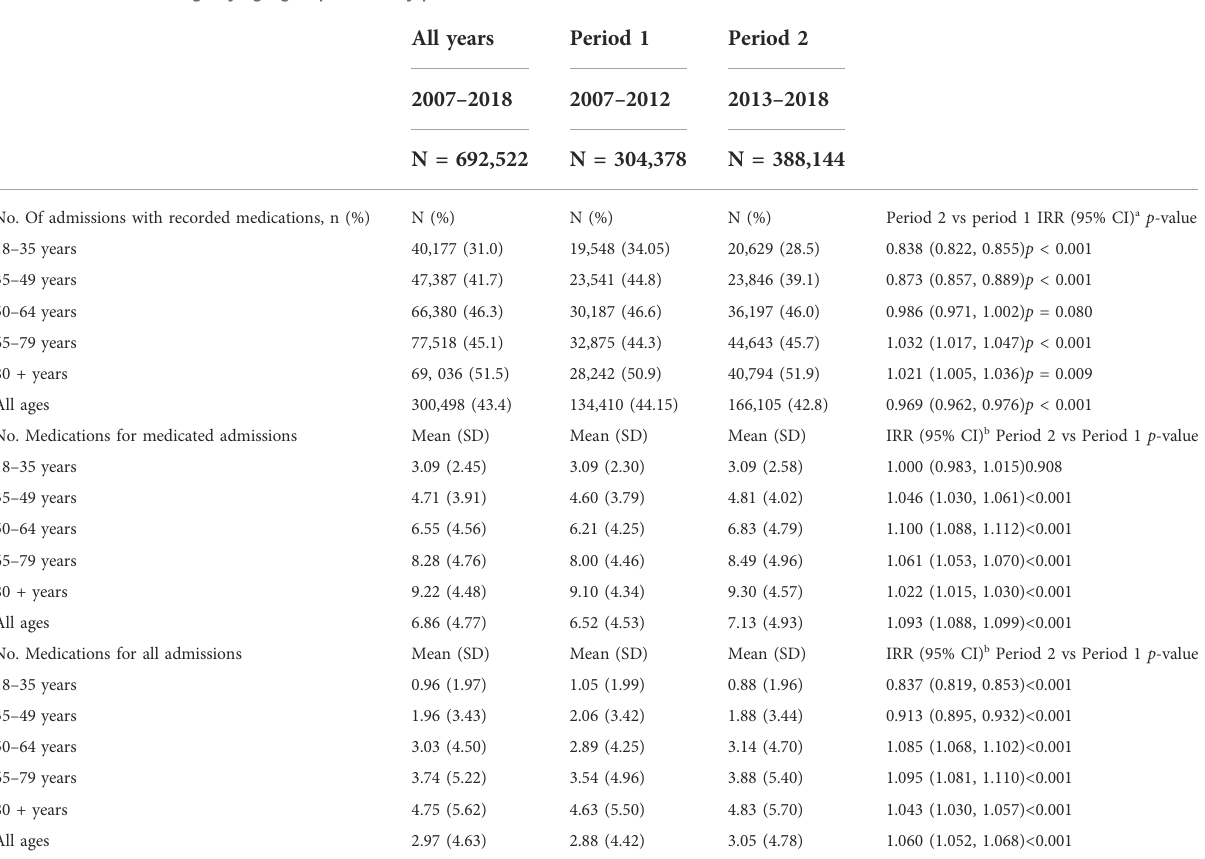
TABLE 2 Medication usage by age-group and study